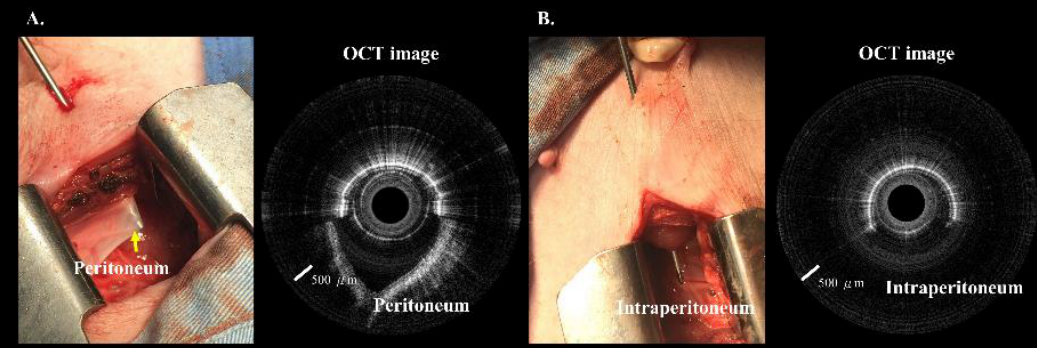
Figure 7. ( A ) Photograph of the incorporated Veress needle at the peritoneum. Around half of the OCT image show the peritoneum. ( B ) Photograph of the incorporated Veress needle punctured through the peritoneum. Around half of the OCT image show the intraperitoneal space.